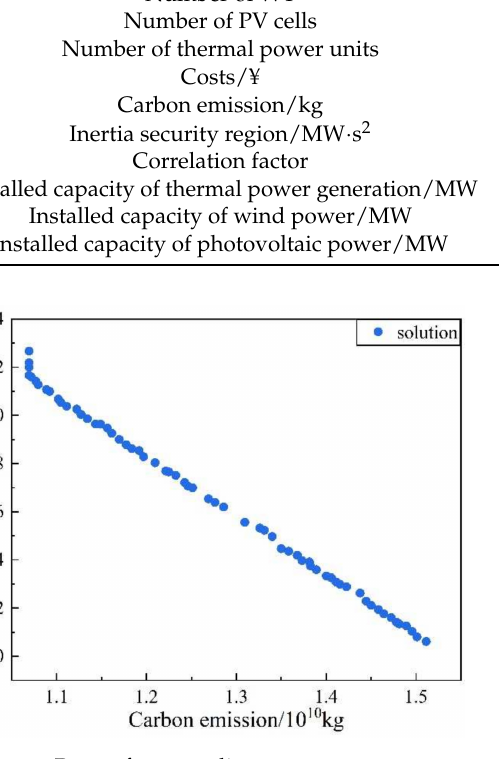
Figure 11. Pareto frontage